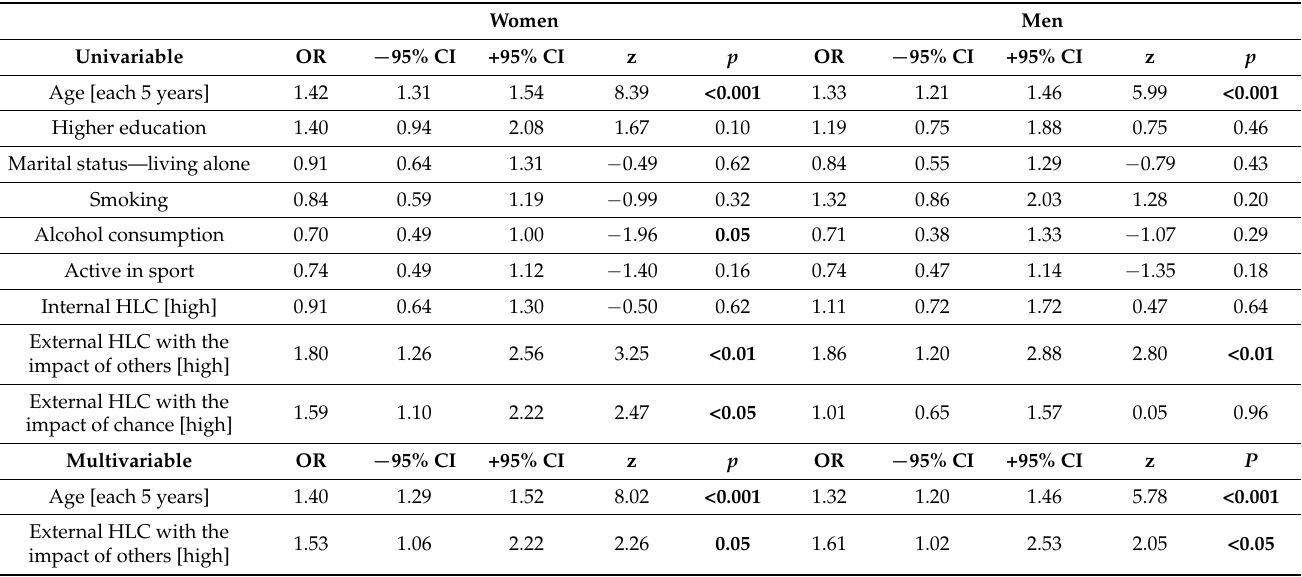
Table 2. Results of the univariable and multivariable ordinal logistic regression for overweight and obesity. Women